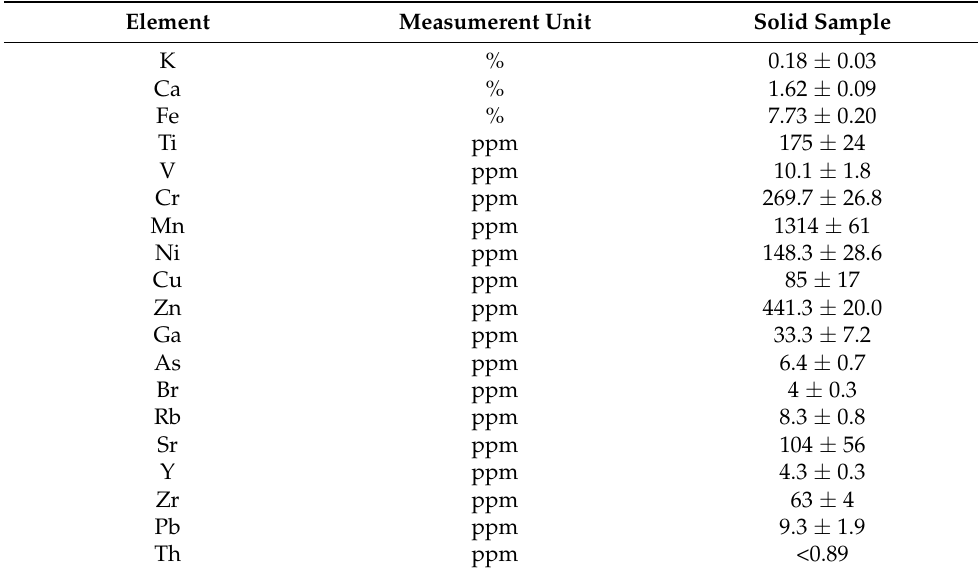
Table 5. Mass concentrations and standard deviations (SD) of elements in electrochemical sludge generated during the treatment of oily wastewater. Element Measumerent Unit Solid Sample